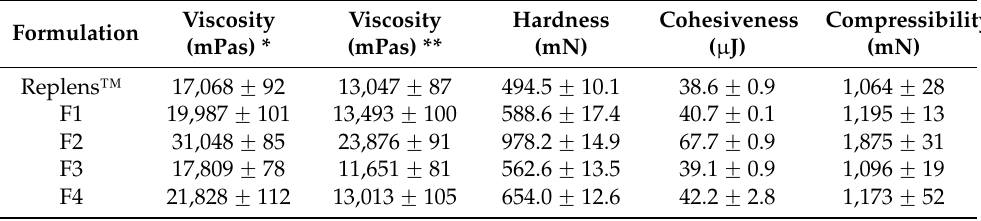
Table 3. Mechanical properties of prepared hydrogels with unmodified or β -GP crosslinked CS compared to Replens™ (mean ˘ SD; n =